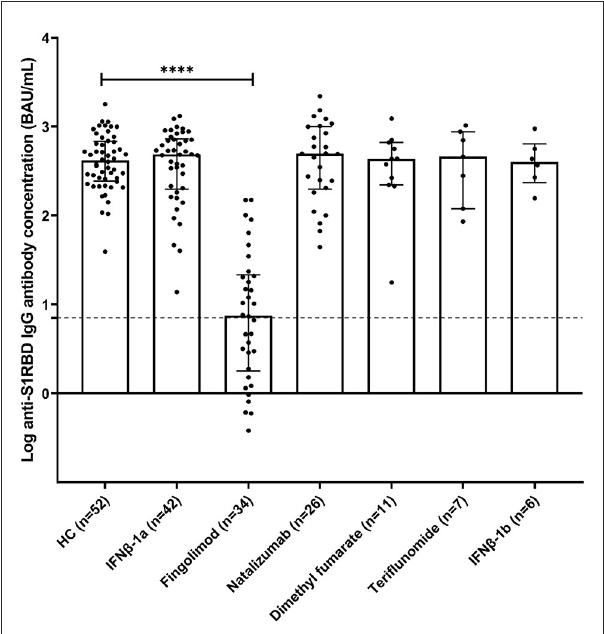
FIGURE1 Anti-S1RBD IgG antibody levels in healthy volunteers (HC) and MS volunteers receiving various DMTs [interferon β -1a (IFN β -1a), interferon β -1b (IFN β -1b), natalizumab, fingolimod, dimethyl fumarate, and teriflunomide]. Bars represent median and interquartile ranges. The dotted line represents the cut-off value (7.1 BAU/mL). **** p < 0.0001.